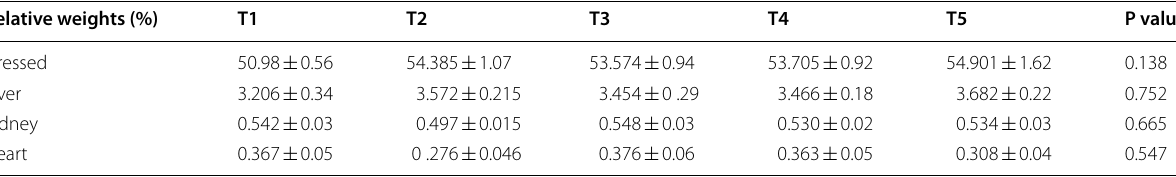
whey powder (7.5 g/kg); T4, T2 whey powder(15 g/kg); + +